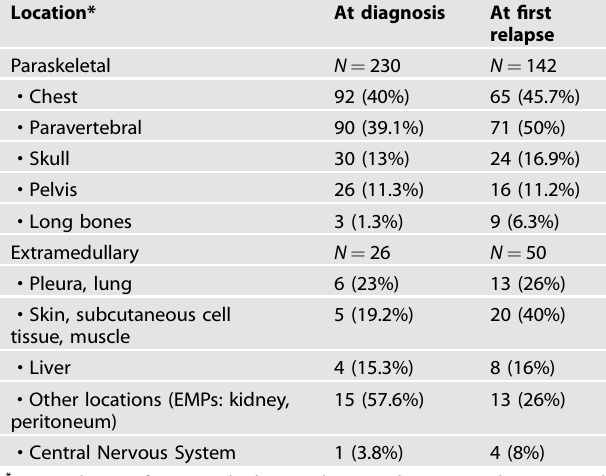
Table 3. Location of plasmacytomas at diagnosis and at fi rst relapse.